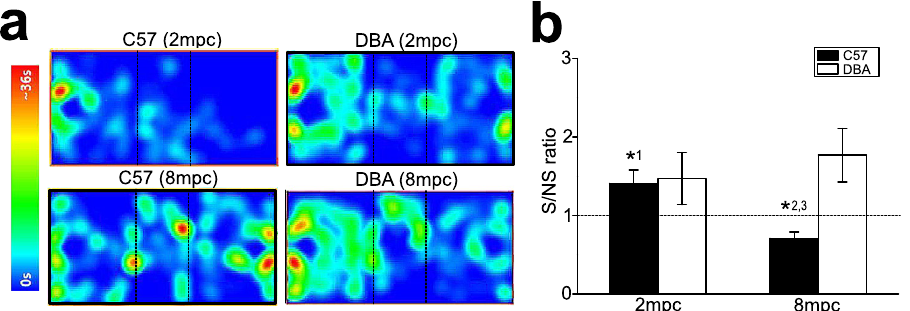
Figure 3. The effects of housing density on sociability of mice in three-chamber test. ( a ) Examples of heat maps showing time and locations in the chamber that C57 and DBA mice under 2 mpc and 8 mpc conditions spent in the three-chamber test. ( b ) A graph showing the ratio of duration to stay at social (S) over nonsocial (NS) sides of the camber. * 1 p = 0.0499 relative to S/NS ratio of 1.0, * 2 p = 0.010 relative to S/NS ratio of 1.0, * 3 p = 0.029 for 2 mpc vs. 8 mpc in